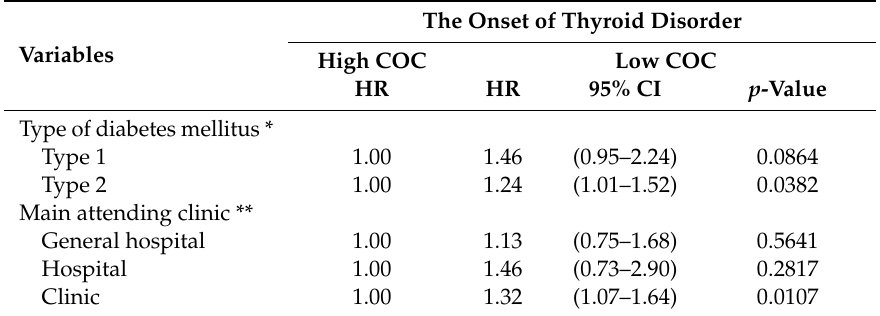
Table 3. The results of subgroup analyses of the association between the continuity of care and the onset of thyroid disorder stratified by the type of diabetes mellitus and main attending clinic. The Onset of Thyroid Variables